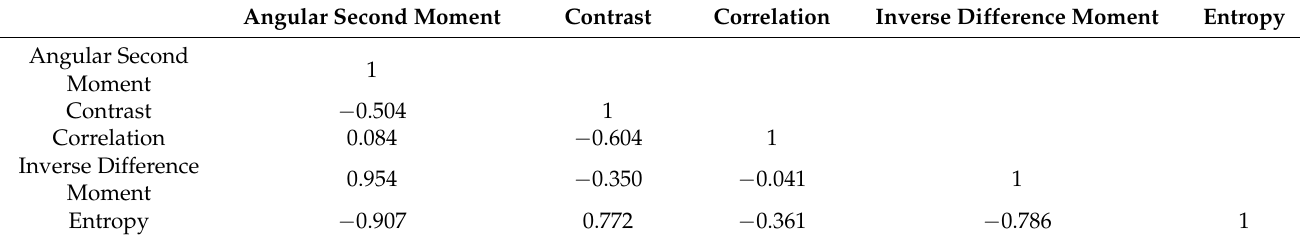
Table 5. The correlation matrix of set